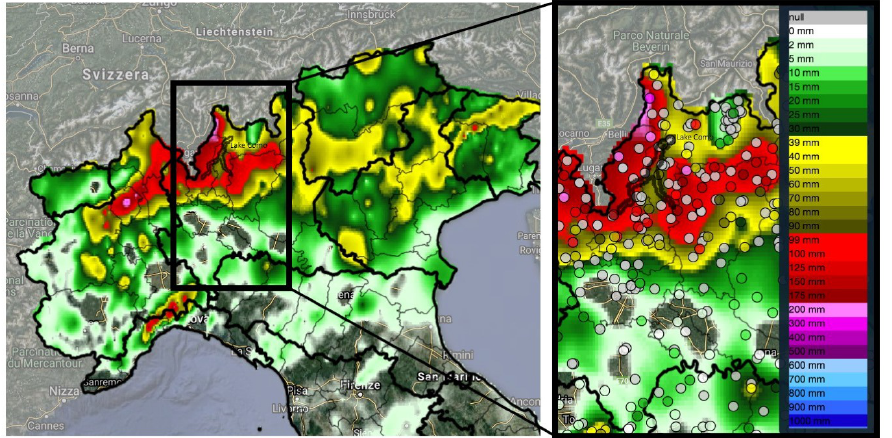
Figure 6. Rain map ( left panel ) and rain gauges overlapped to rain map ( right panel ) focused on the area of interest (blue square identifies Lake Como)—accumulated rainfall over the whole period from 24 July 2021 at 00:00 UTC to 28 July 2021 at 23:55 UTC